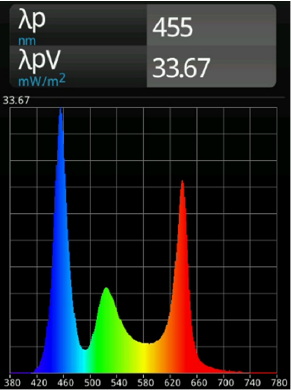
Figure 2. Spectral power distribution of the light impinging on the surface of the train (only the LED of the VLS unit as a light source).